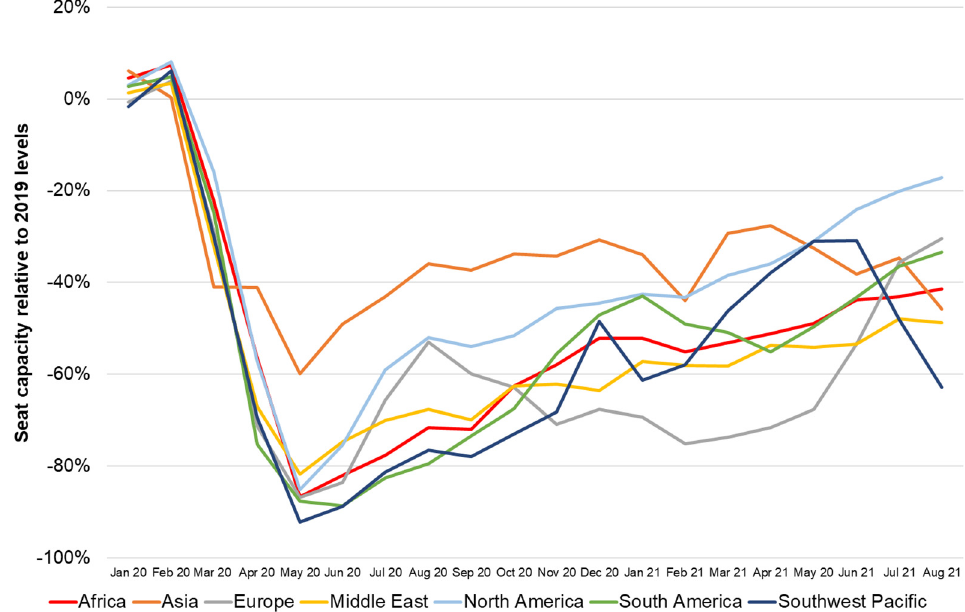
Figure 6. Development of total seat capacity by region between Jan 20 and Aug 21 relative to 2019 levels [38], [own illustration].